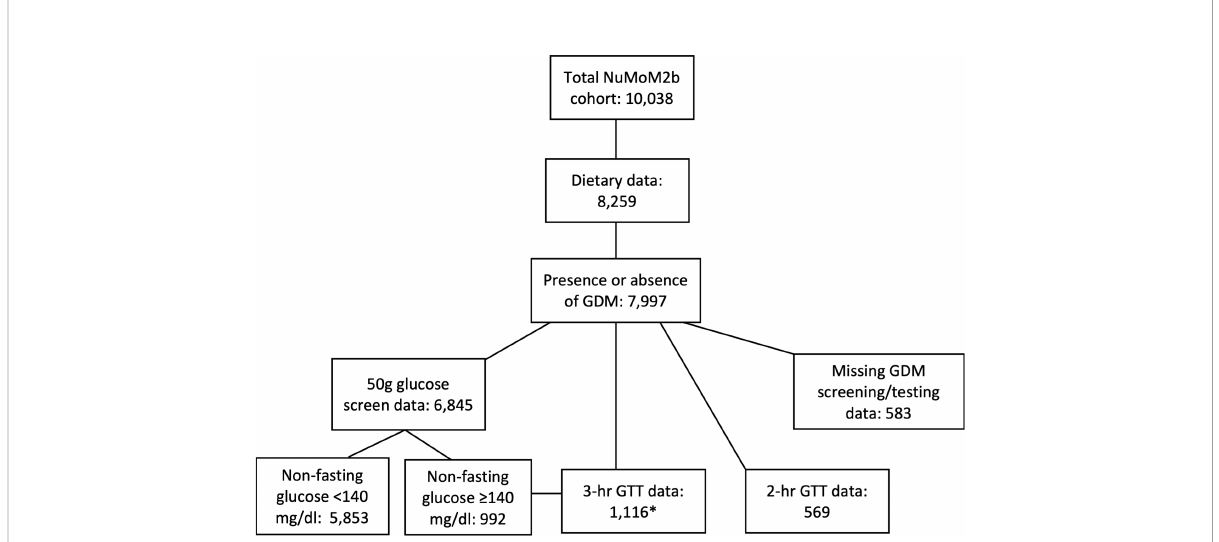
FIGURE 1 Flowchart of participants for the present analysis. Number of study participants with available data for presence or absence of GDM, diet quality, GDM screening, and GDM diagnostic testing. *3-hr GTT data available for 992 participants with a raised glucose concentration on the 50g screening test, plus 124 additional participants with other GDM risk factors who did not undergo a screening test. GDM, gestational diabetes mellitus; GTT, glucose tolerance test; NuMoM2b, Nulliparous Pregnancy Outcomes Study: Monitoring